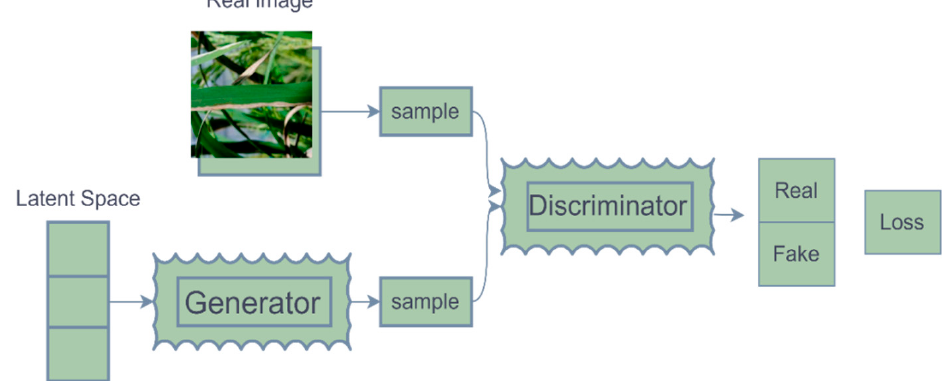
Figure 6. GAN process.